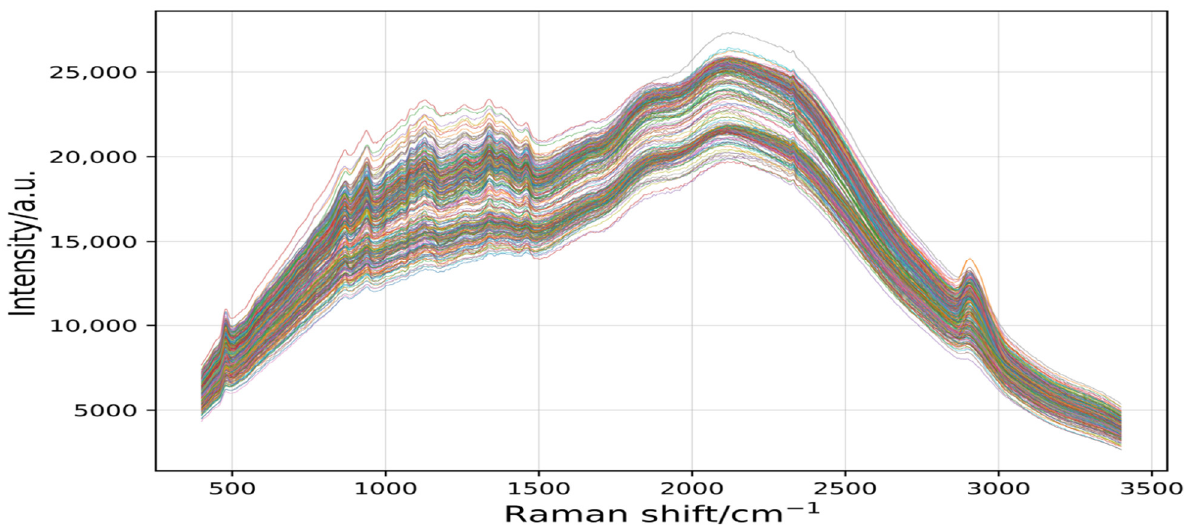
Figure 4. The 245 raw spectral curves for 7 varieties. Raman shift is the reciprocal of wavelength, and its range is 200–3400 cm −1 . Intensity is the intensity of Raman scattering.